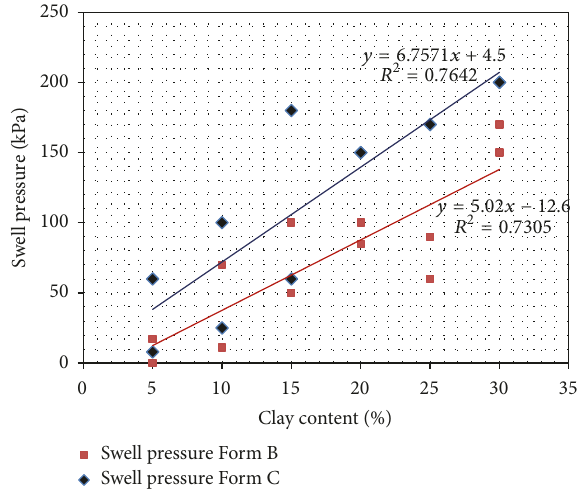
Figure 8: Swelling pressure of sand-clay